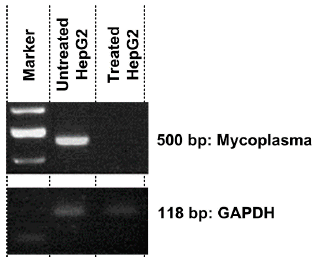
Figure 1. Mycoplasma detection in the HepG2 cells by polymerase chain reaction (PCR) before and after BM-Cyclin treatment ( n = 3). glyceraldehyde-3-phosphate dehydrogenase (GAPDH) served as an internal control . bp, base pair .